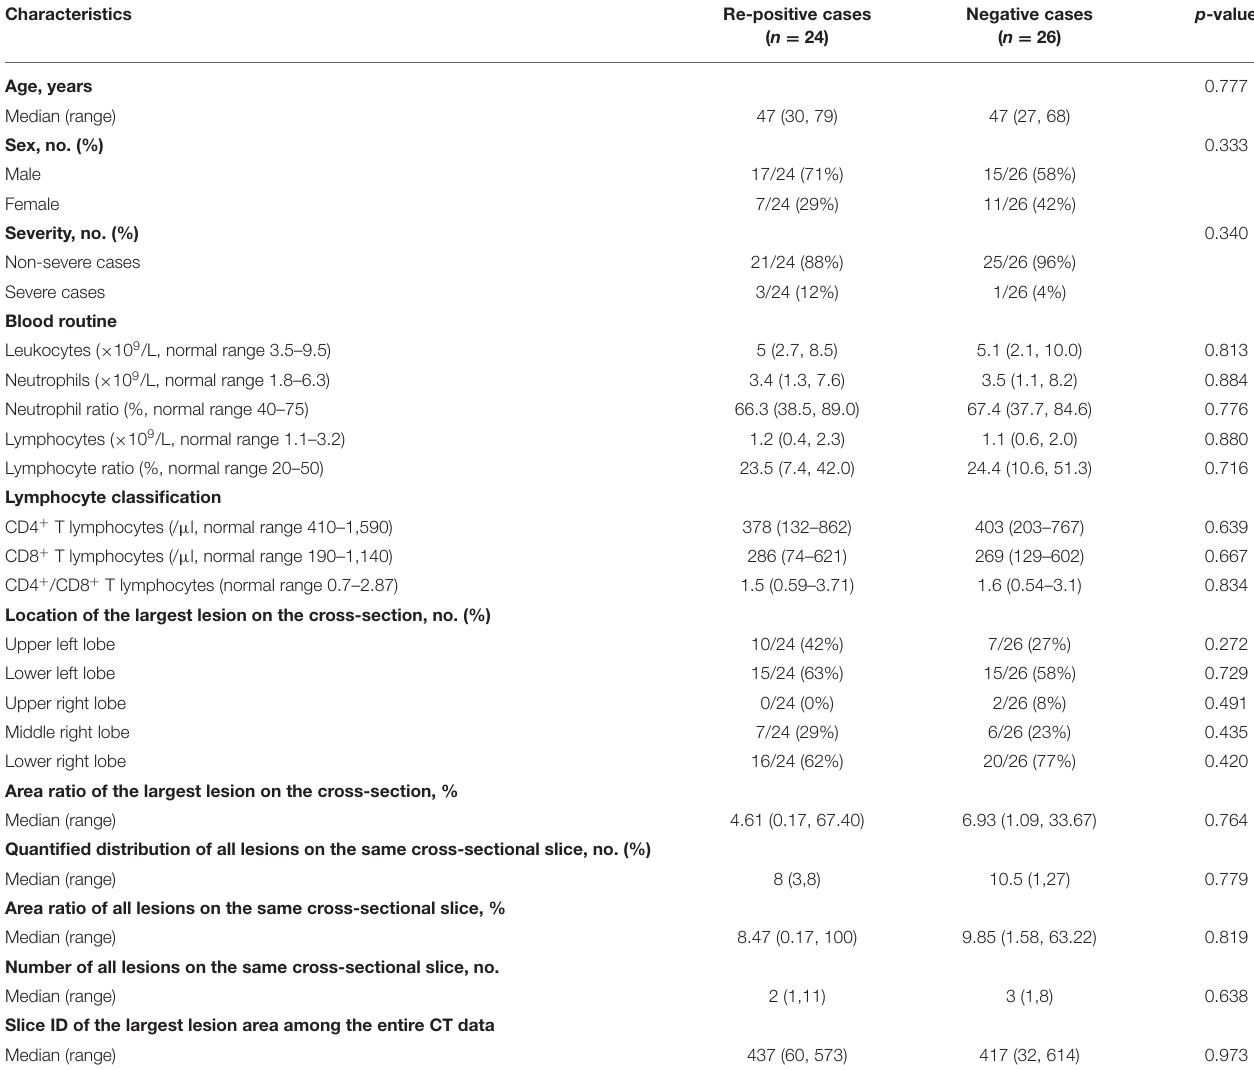
TABLE 1 | Baseline demographics and clinical characteristics of the patients involved in this research.